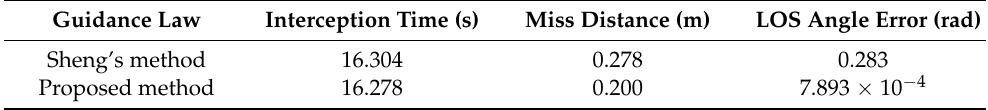
Table 7. Interception times, miss distances, and LOS angle errors of two guidance laws with α = 0.3. Guidance